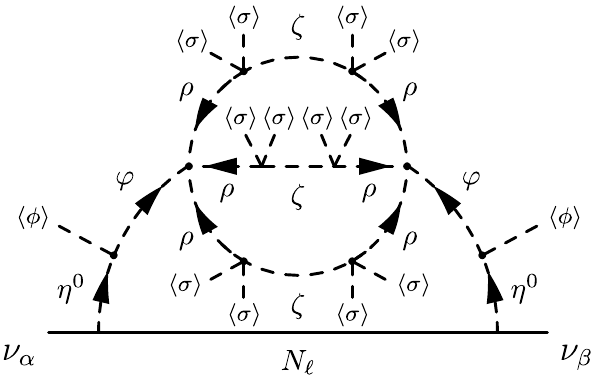
Figure 1 . Scotogenic loop for light active neutrino masses where ‘ = 1 , 2 and α, β = e, µ, τ